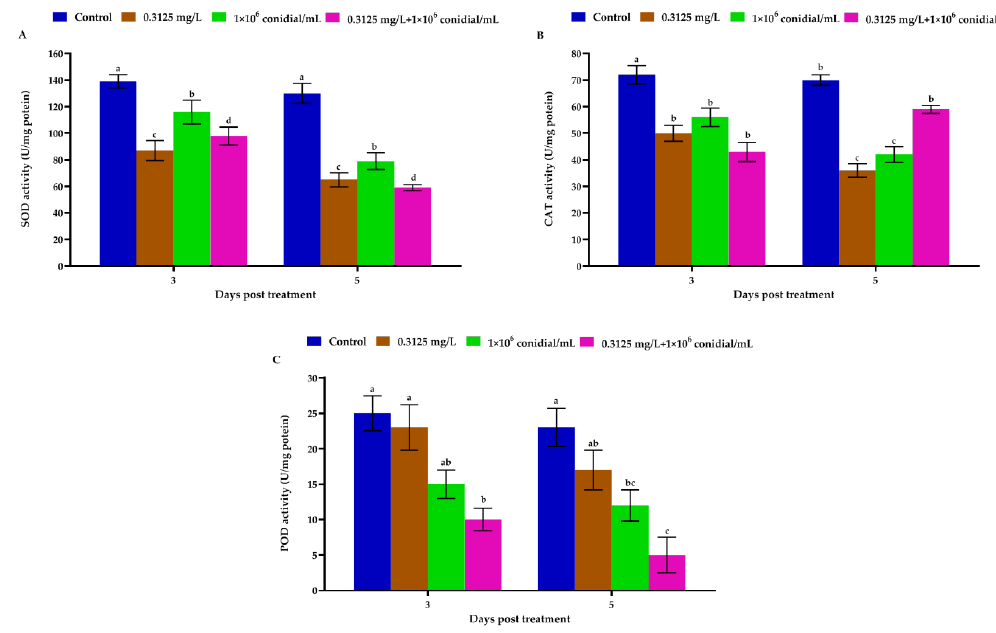
Figure 5. Antioxidant enzyme activities of M. usitatus ( N = 9) in response to single or combined treatments of B. bassiana and emamectin benzoate) at 3 and 5 days post-treatment. ( A ) Activity of superoxide dismutase (SOD), ( B ) catalase (CAT), ( C ) and Peroxidase (POD). Error bars indicate standard error of means based on three replicates. Different letters on bars indicate significant dif- ferences among treatments at different periods of time (Tukey’s test at 5% level of